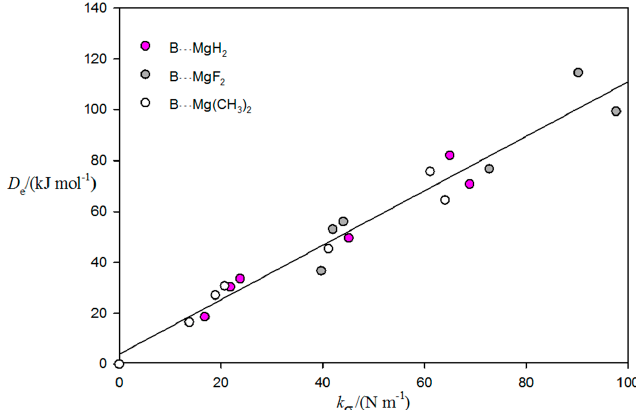
Figure 7. Variation of ab initio calculated values of D e with k σ for 18 B···MgR 2 complexes (R =F, H or CH 3 ; B = CO, HCN, H 2 O, NH 3 , H 2 S or PH 3 ). For the linear regression, R 2 =